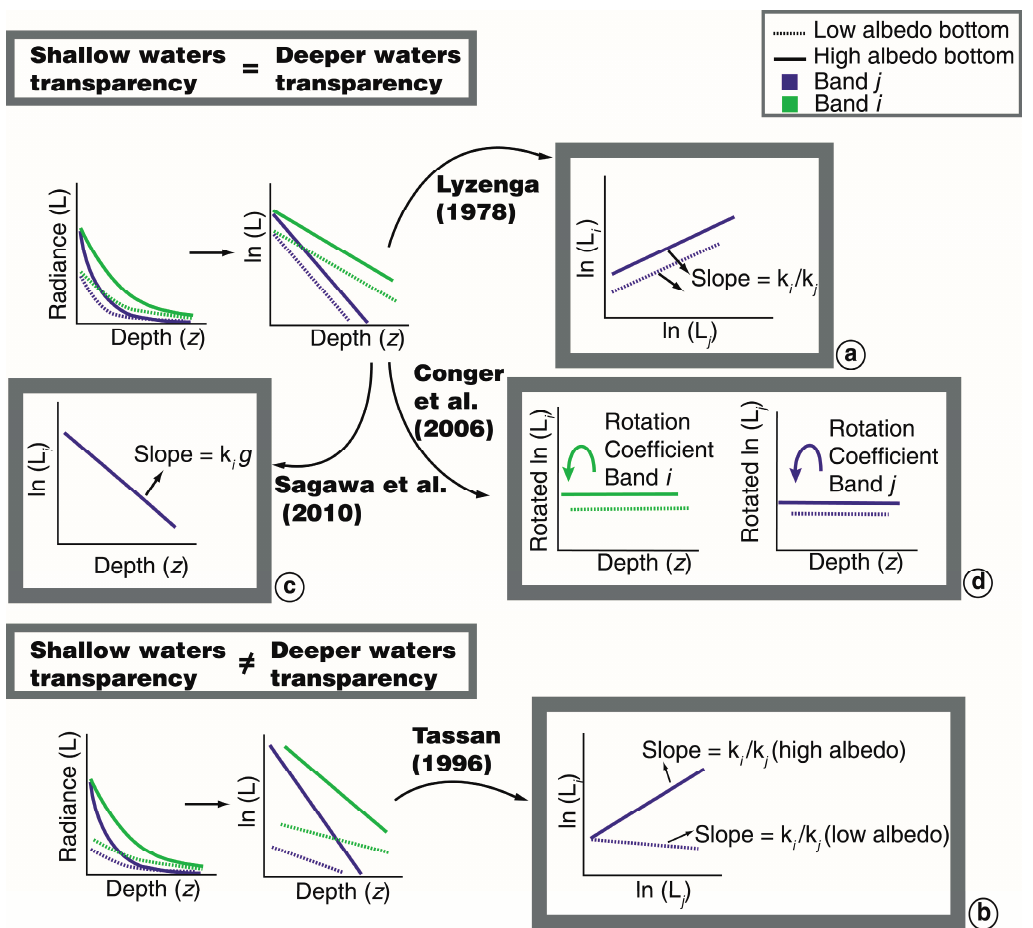
Figure 2. Different strategies proposed to obtain diffuse attenuation coefficient ( (cid:1837) a remote sensing image. These methodologies work with samples of radiance in pixels where depth is known. ( a ) Lyzenga [35]; ( b ) Tassan [37]; ( c ) Sagawa et al. [38]; ( d ) Conger et al.